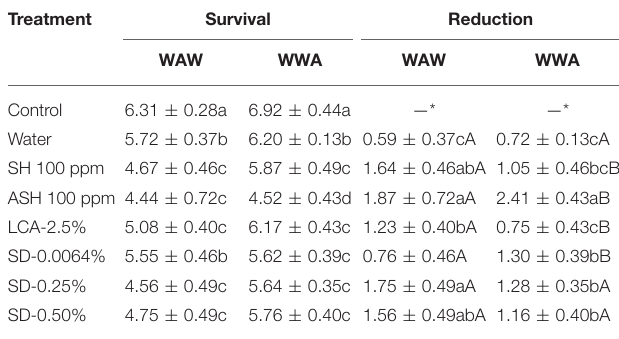
— * Indicates reduction data are not available. Mean values with different lowercase letters within a column are significantly different ( P < 0.05) . Mean values with different capital letters within a row are significantly different ( P < 0.05) . samples showed similar ( P > 0.05) reductions (1.63–1.98 log greater ( P < 0.05) reductions than SH (1.32 log CFU/tomato)